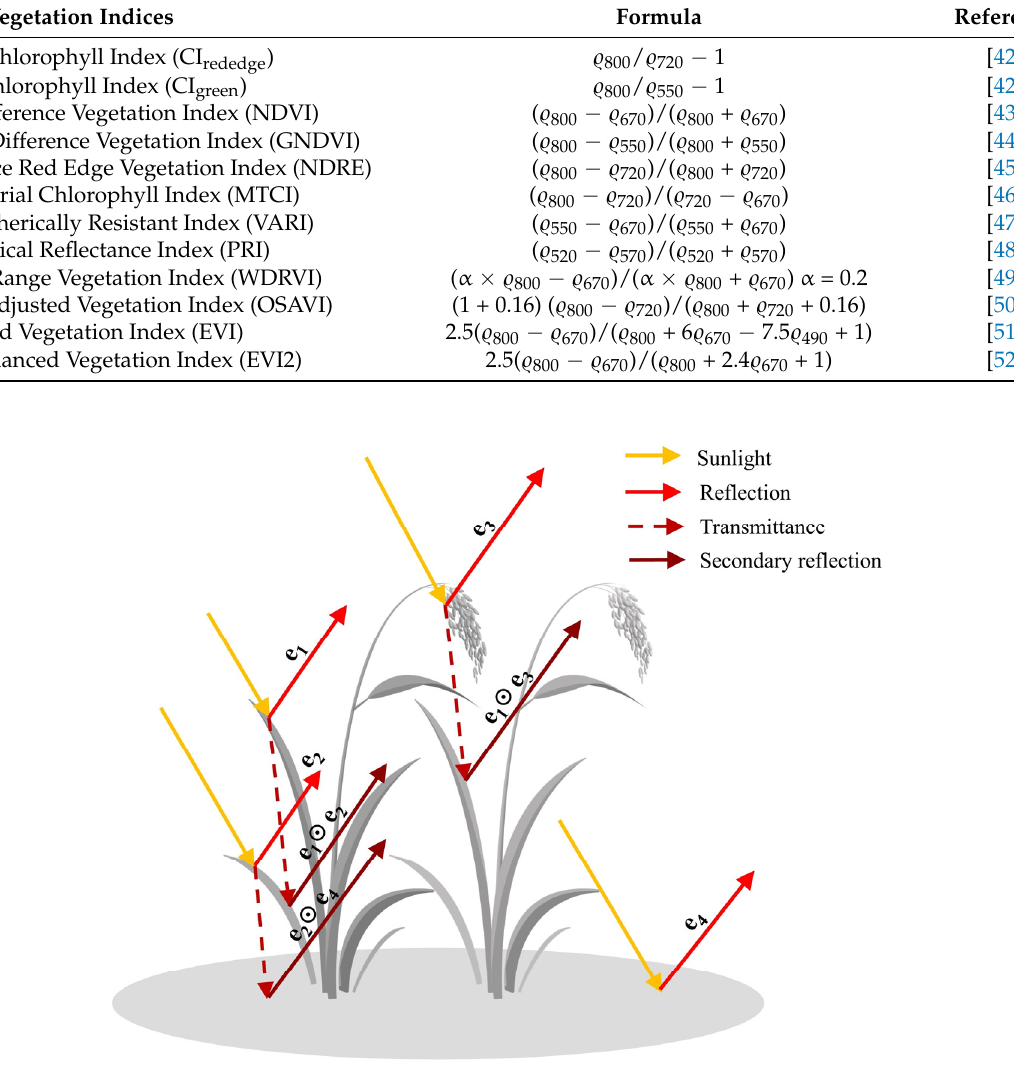
Figure 4. Schematic representation of the multilayer characteristics of paddy rice spectra .